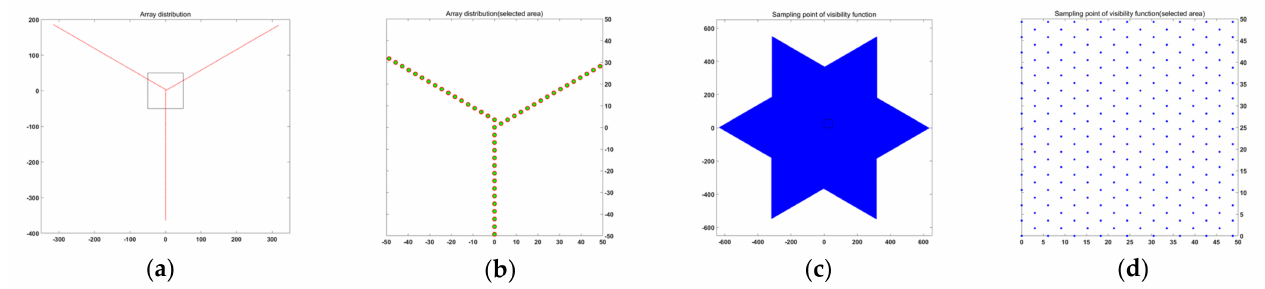
Figure 6. The antenna array ( a , b ) (partial zoomed—in view) and resulting UV plane sampling pattern ( c , d ) (partial zoomed-in view) of